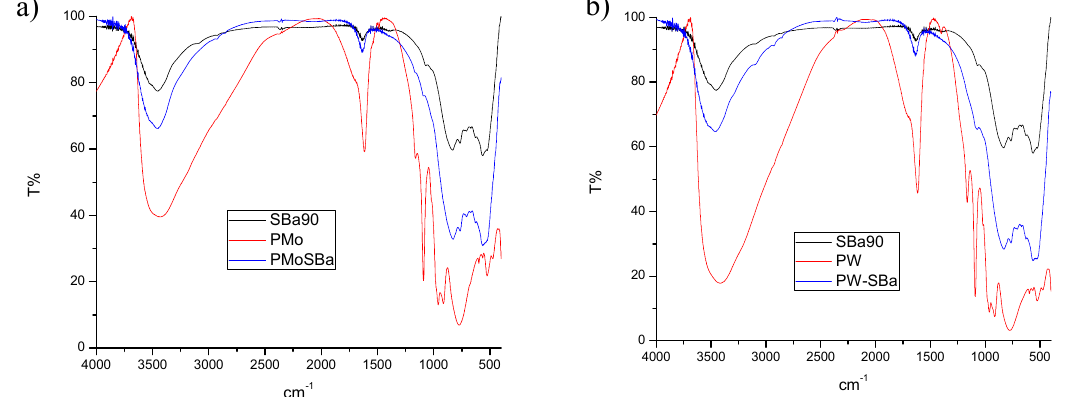
Figure 1. FT-IR spectra of the support, active phase, and catalysts; ( a ) Al 2 O 3 (black), PWMo (red) and PWMoAl 2 O 3 (blue); ( b ) Al 2 O 3 (black), PW (red) and PWAl 2 O 3 (blue).